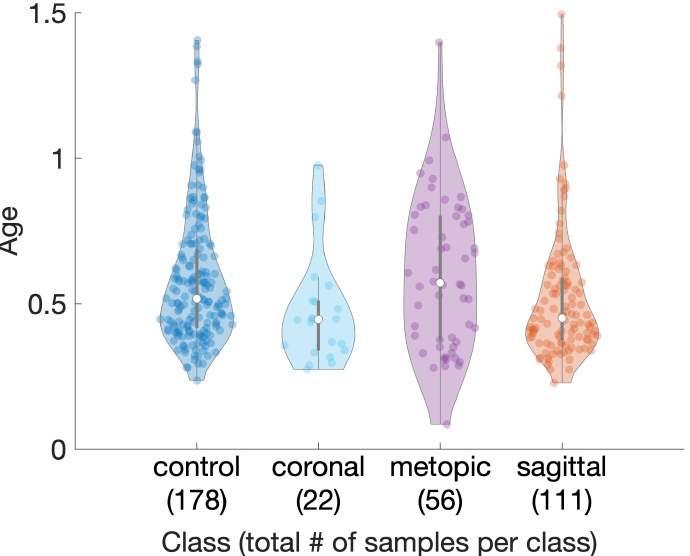
Figure 2. Age distribution among classes of the dataset. Parenthesis indicate number of samples per